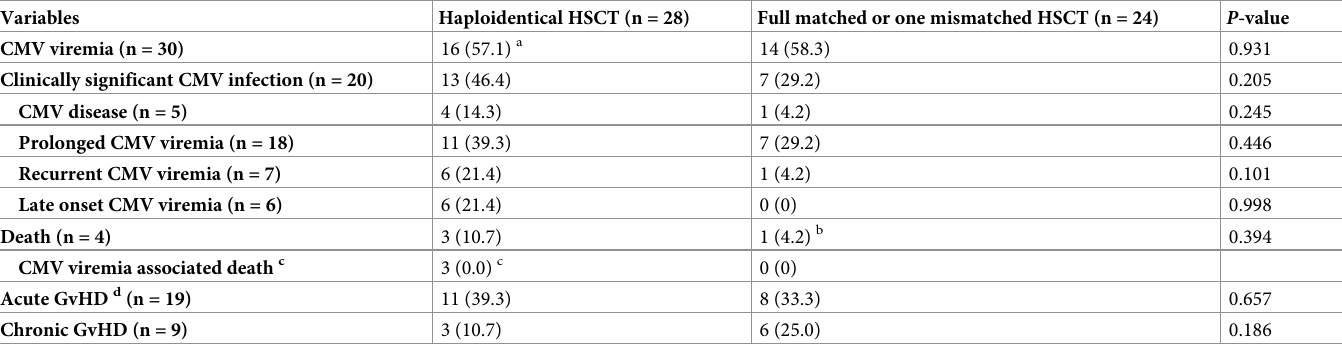
Table 2. Clinical outcomes including CMV infections according to the type of